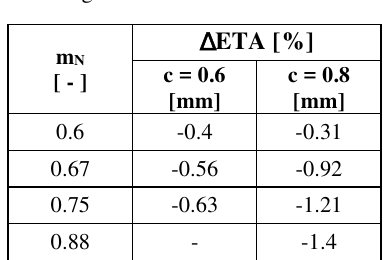
Table 3. Decrease of the efficiency at Ma 2u = 0.9 for higher values of clearance width .